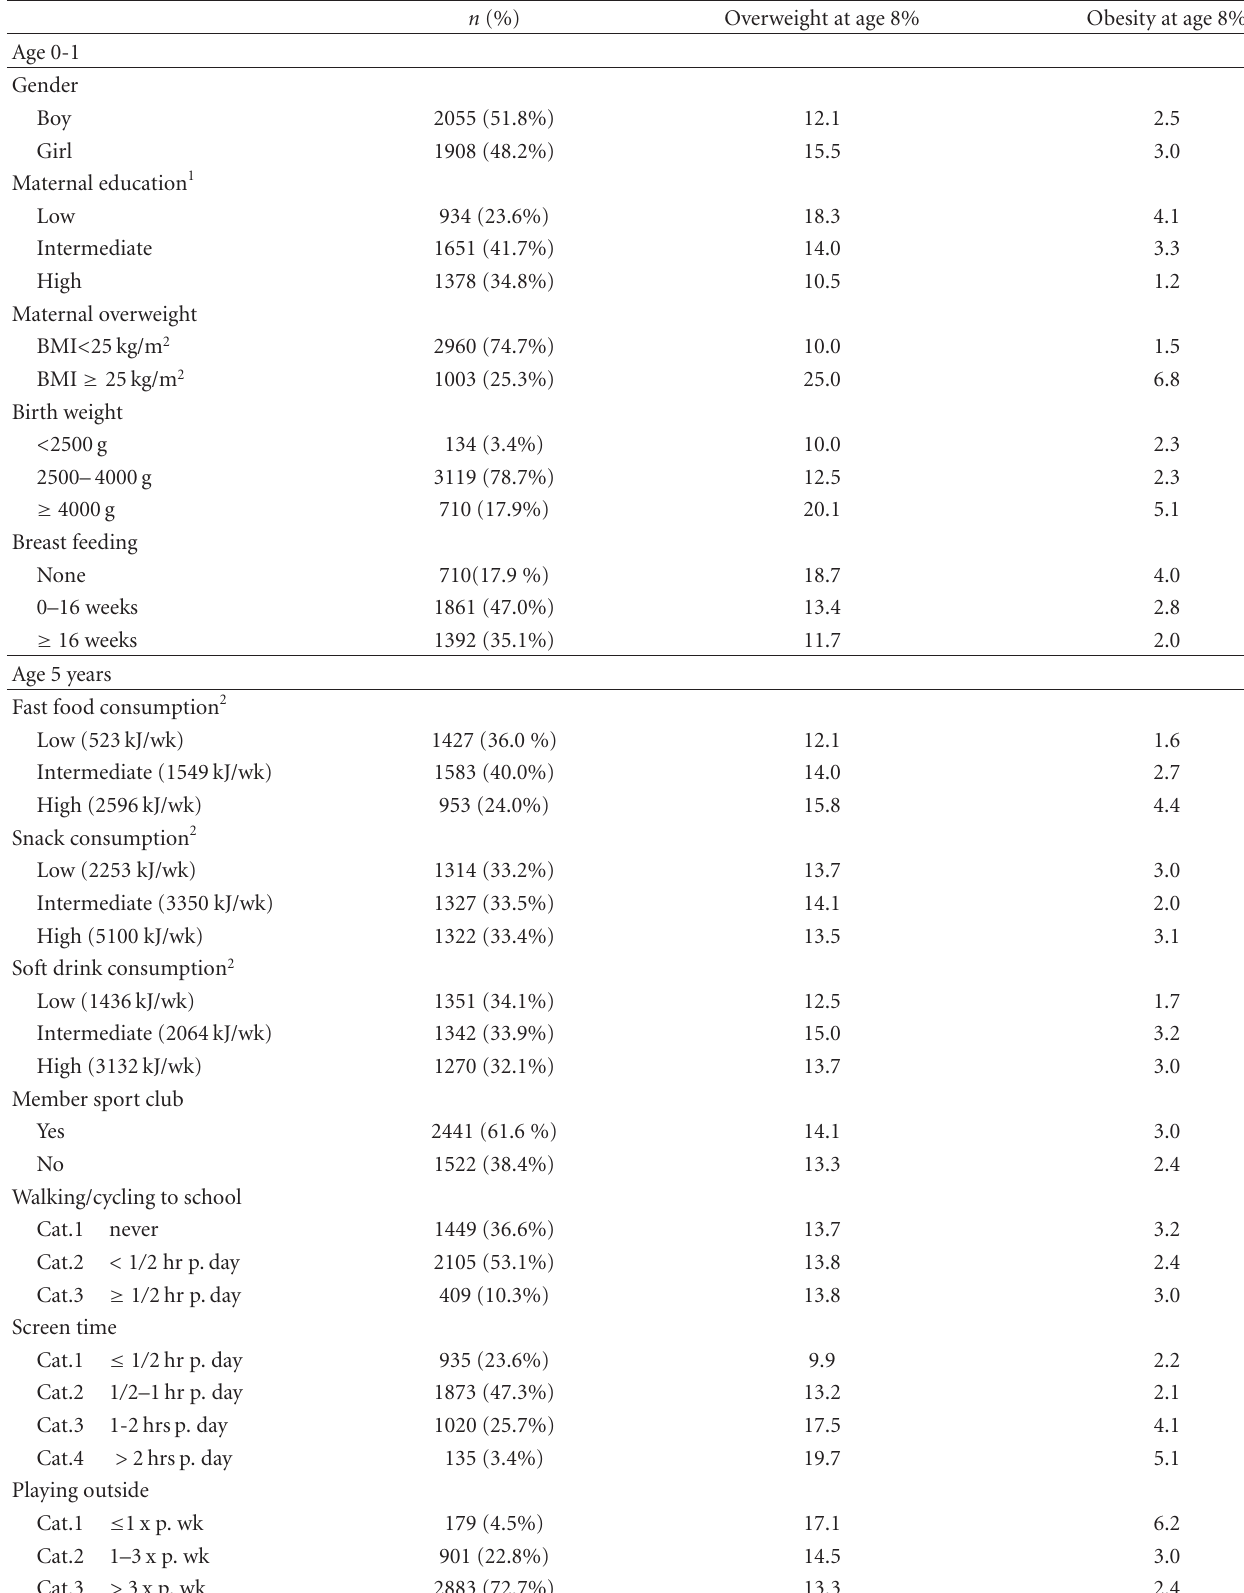
Table 1: Characteristics of the study population and prevalence of overweight (including obesity) and obesity at the age of 8 years in sub groups of the population. n (%) Overweight at age 8% Obesity at age